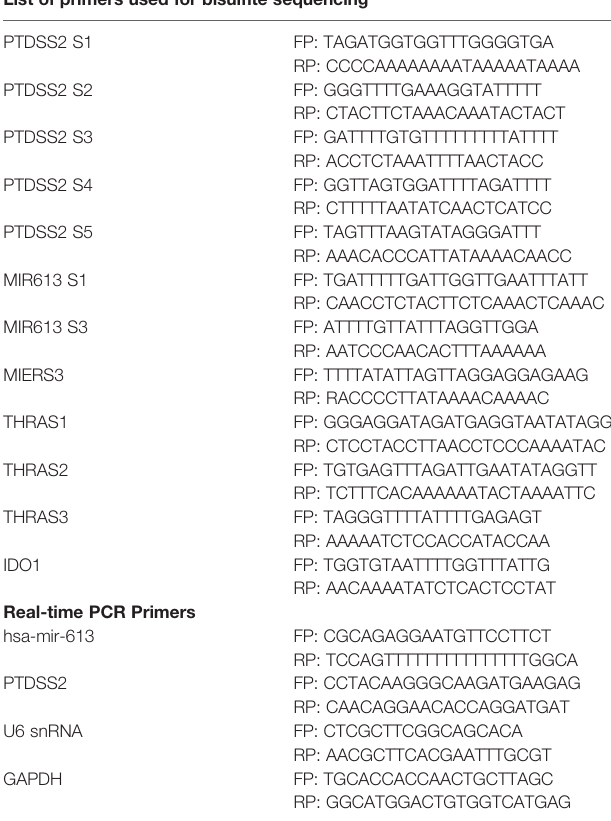
TABLE 1 | List of primers. List of primers used for bisul fi te